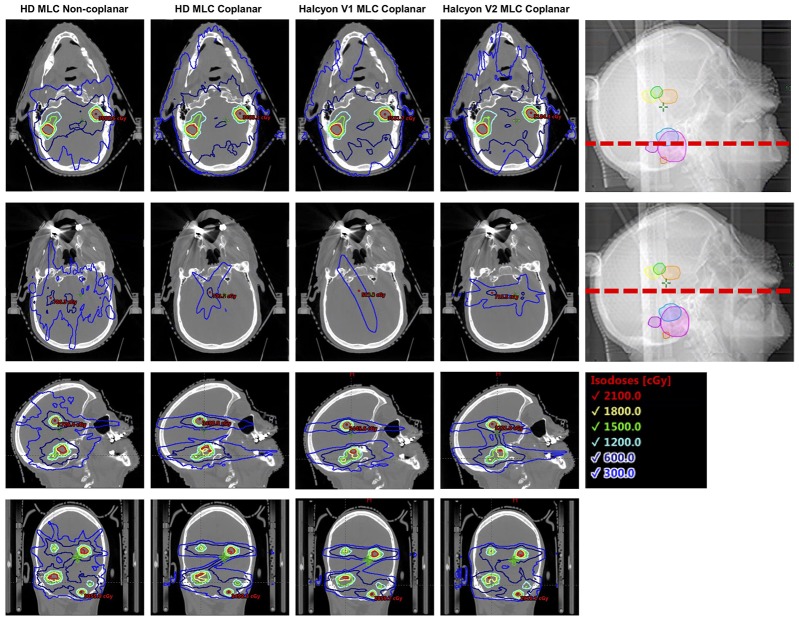
Illustration of dose fall-off characteristics across multiple different delivery techniques, both in and outside the target plane. Non-coplanar beam arrangements in general have better dose fall-off in the target plane (top row), but bears more low dose spread to tissue between target planes (2nd row).